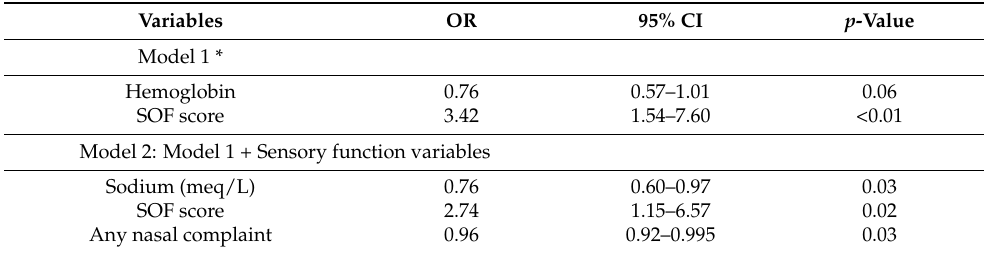
Table 2. Regression analysis with having an impaired appetite as the dependent variable ( n = 78). Variables OR 95% CI p -Value